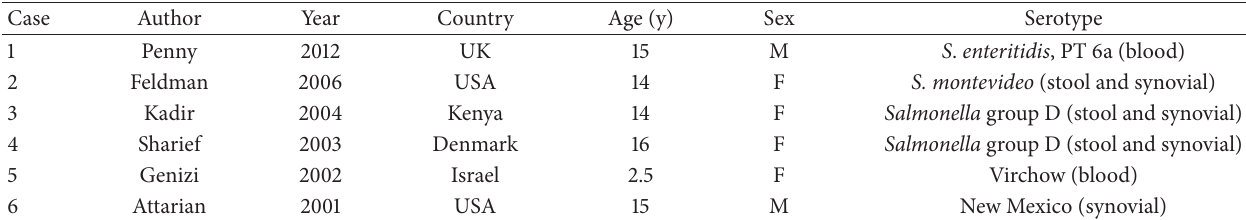
Table 1: Case reports of Salmonella sacroiliitis in children since